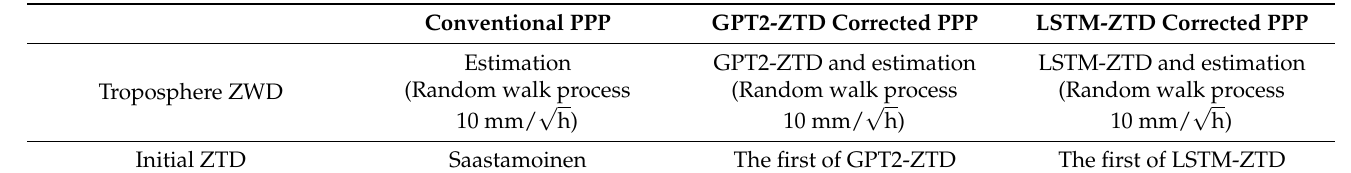
Table 4. Processing solutions of